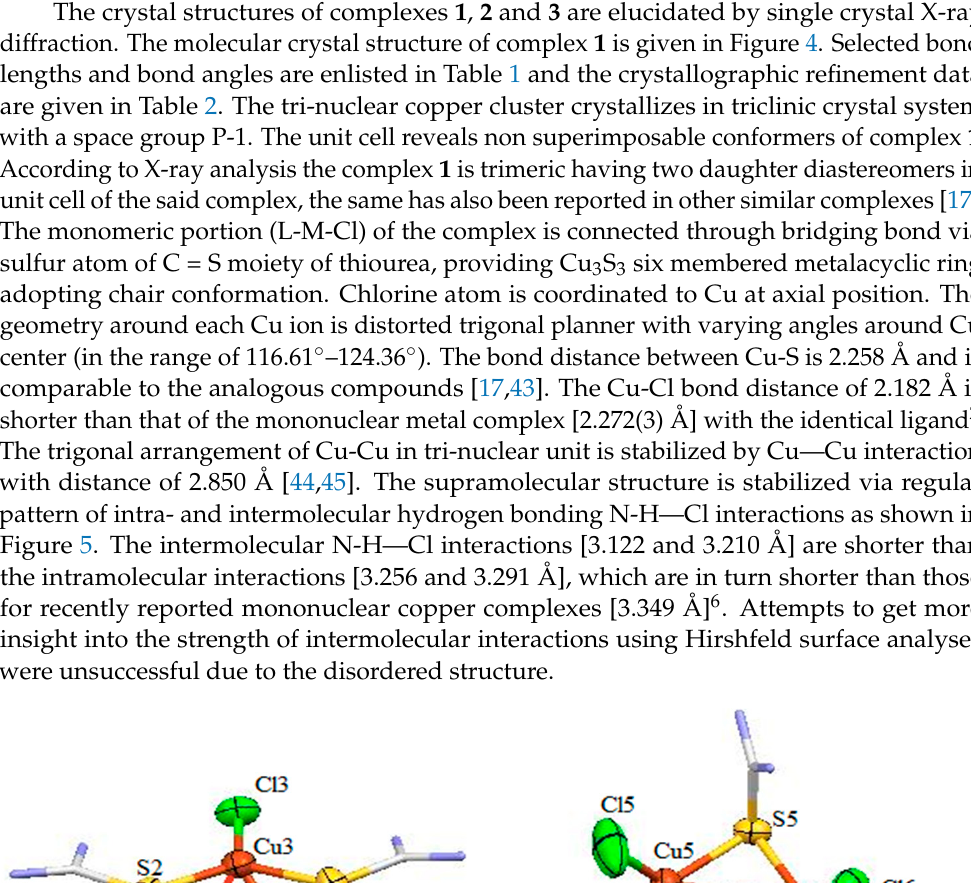
Figure 5. 2D representation of 1, the network is stabilized by intermolecular and intramolecular N- H---Cl type interactions. 3.2. Description of Crystal Structure of [Ag 2 L 6 ](NO 3 ) 2 ( 2 ) The molecular crystal structure of complex 2 is shown in Figure 6 and the selected bond lengths and bond angles are enlisted in Table 1. The bimetallic silver complex crys- tallizes in triclinic crystal system with space group P-1. The binuclear complex 2 consists of two Ag(I) ions and six thiourea ligands. Both silver ions are bridged by S-atom of the two 1,3-diisobutyl thiourea ligands, forming four-membered Ag-S-Ag-S ring. Thiourea derivatives have different coordination mode for silver(I) ions. Two thiourea ligands are linked in terminal fashion to each metal ions and the remaining two thiourea ligands bridged both metal ions together. In this binuclear complex each silver atom is tetrahe- drally coordinated through S-atom of the two terminal thiourea and two bridging thiou- rea molecules. The interatomic distance between Ag and S(bridged) is 2.622 Å. As ex- pected, this distance is longer than the respective Ag-S (terminal) bond (2.491 Å) and is